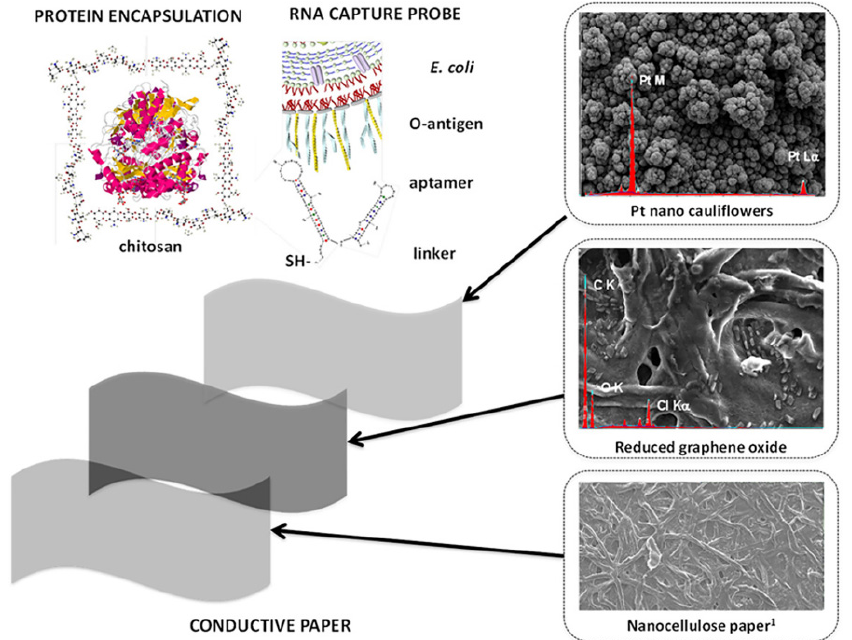
Figure 12. Conductive paper made of graphene–nanocellulose strips decorated with platinum nano- cauliflowers. The paper can be functionalized with glucose oxidase encapsulated in chitosan or RNA for biosensing purposes. Reproduced with permission from Burrs et al., Biosens. Bioelectron.; published by Elsevier, 2016 [195].